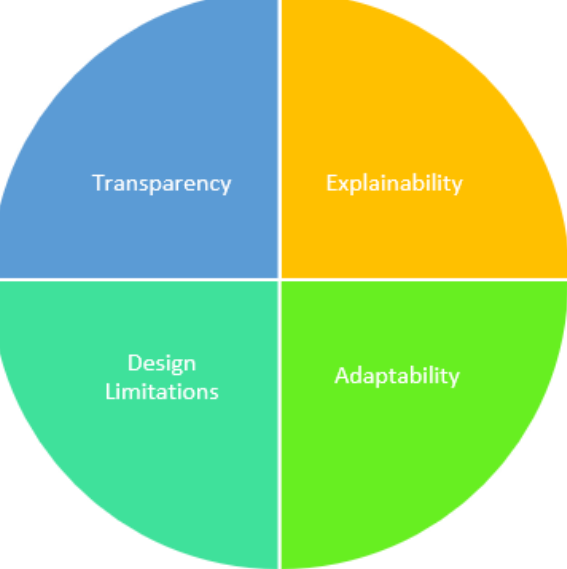
Figure 2. Difference in AI and XAI Methods.